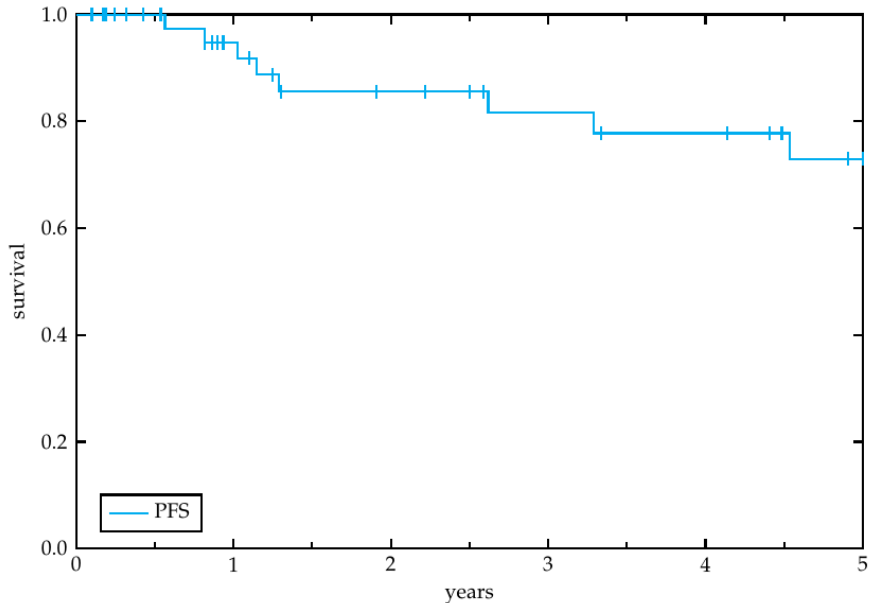
Figure 3. Progression free survival. Kaplan-Meier plot showing the progression free survival of the 46 patients, enrolled in this study, within the 5-year peroid after radiotherapy initiation.